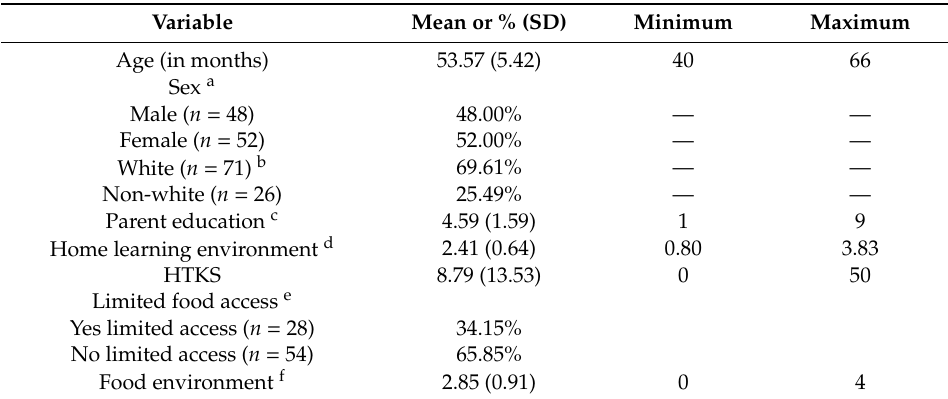
Table 1. Descriptive means and standard deviations for full sample ( N =